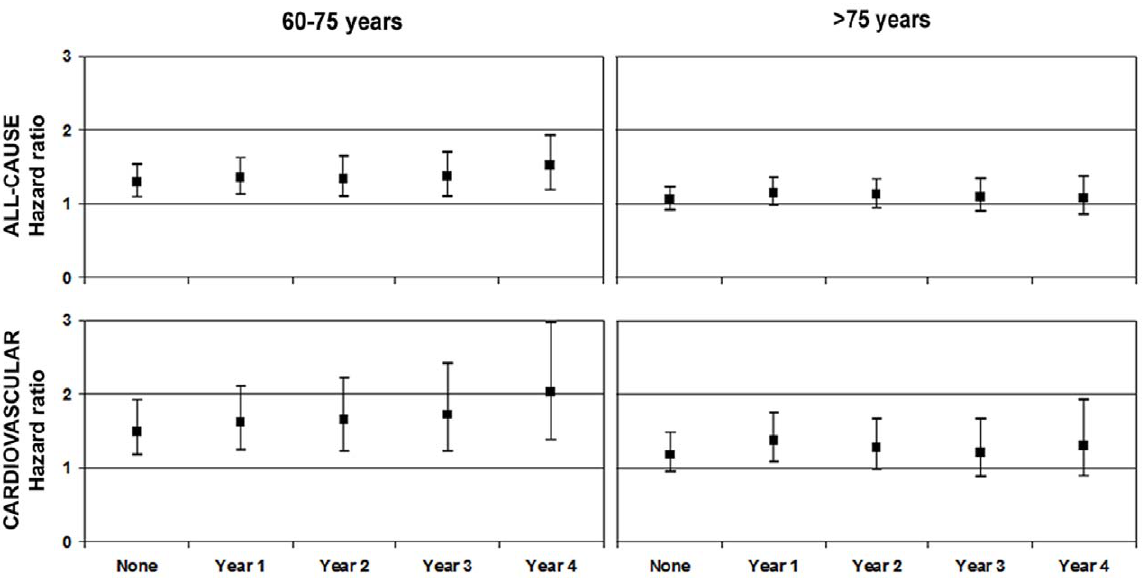
Figure 3. Exclusion of early mortality. Hazard ratios and their 95% confidence intervals (adjusted for confounders) of LDL-cholesterol for all- cause and cardiovascular mortality after exclusion of the deaths in the first follow-up years. Hazard ratios of several analyses in both age groups are presented: an analysis including all follow-up years, an analysis in which the first year of follow-up was excluded, an analysis in which the first two years of follow-up was excluded and so